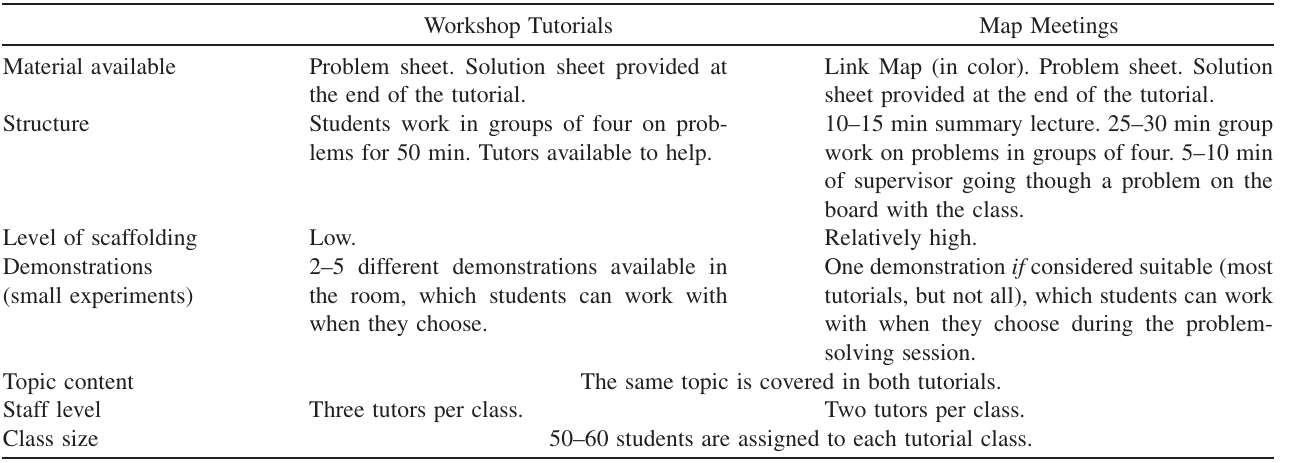
TABLE I. Comparing the two different tutorial